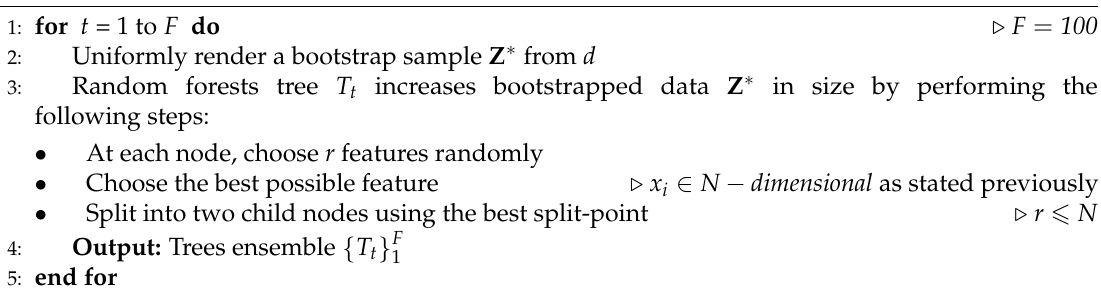
Algorithm 1 Training using the random forests algorithm.